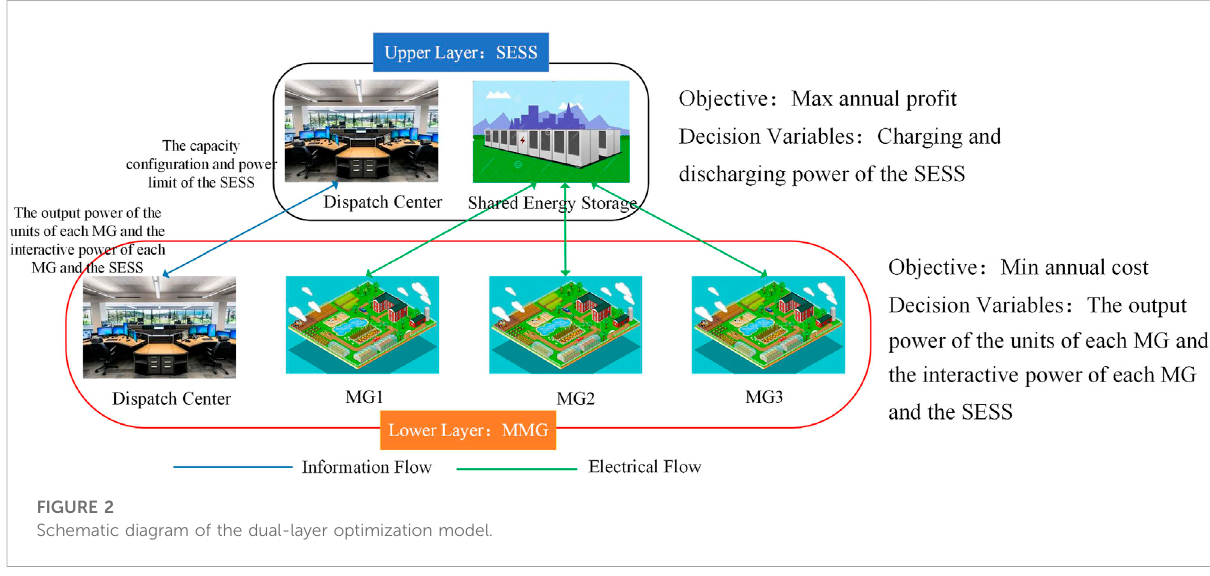
FIGURE 2 Schematic diagram of the dual-layer optimization